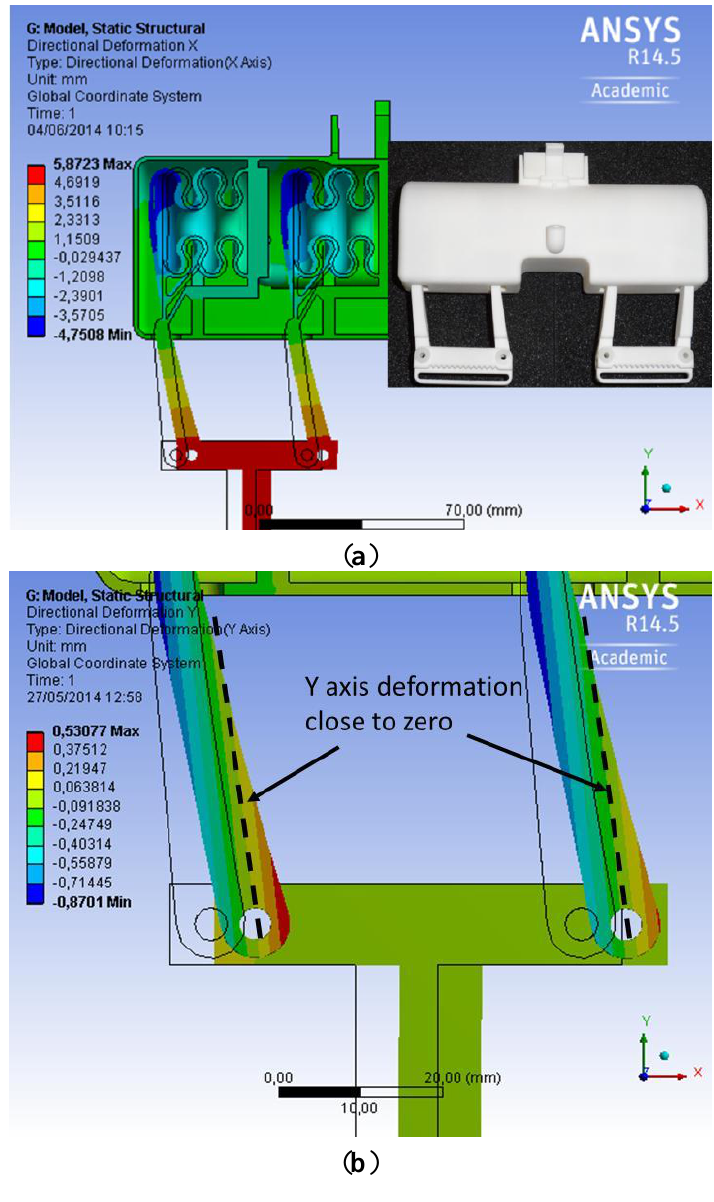
horizontal displacement of one finger at 0.4 MPa. ( b ) Analysis of the vertical displacement. The dotted line represents points where shaft centers can be located to get only horizontal motion in